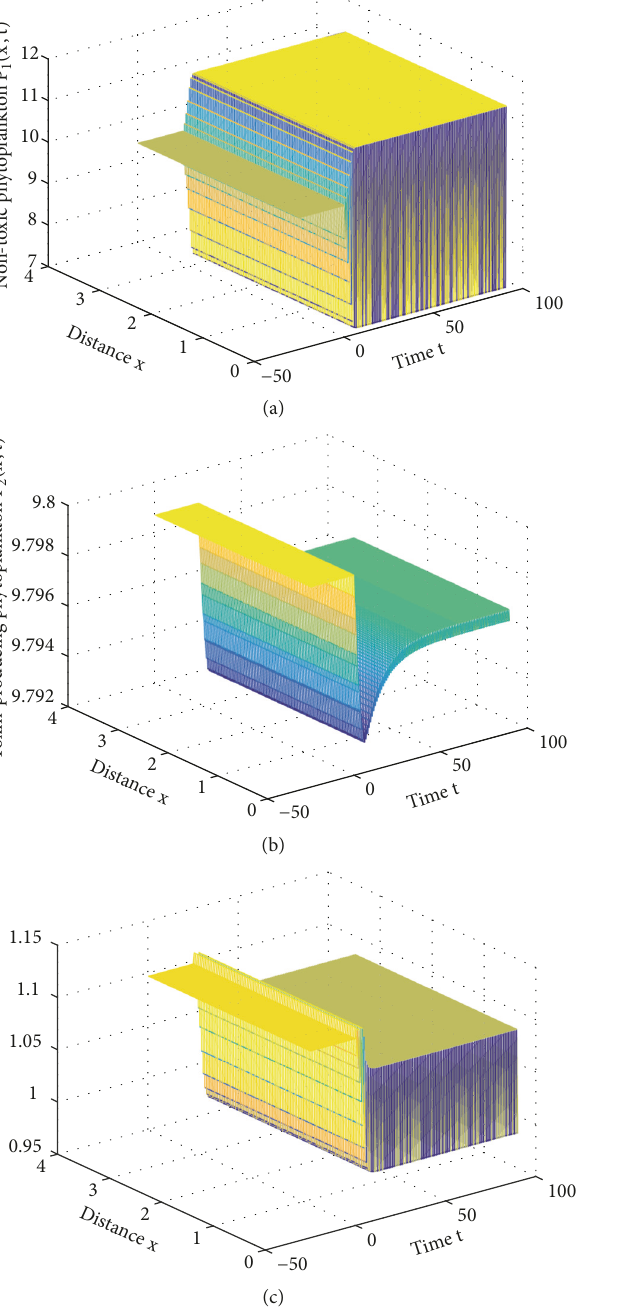
Figure 4: The spatially homogeneous periodic solution exists when 𝜏 = 25 > 𝜏 0 . Figure 5: The equilibrium solution 𝐸 ∗ of (3) is asymptotically stable when 𝜏 = 2.5 with new coefficient